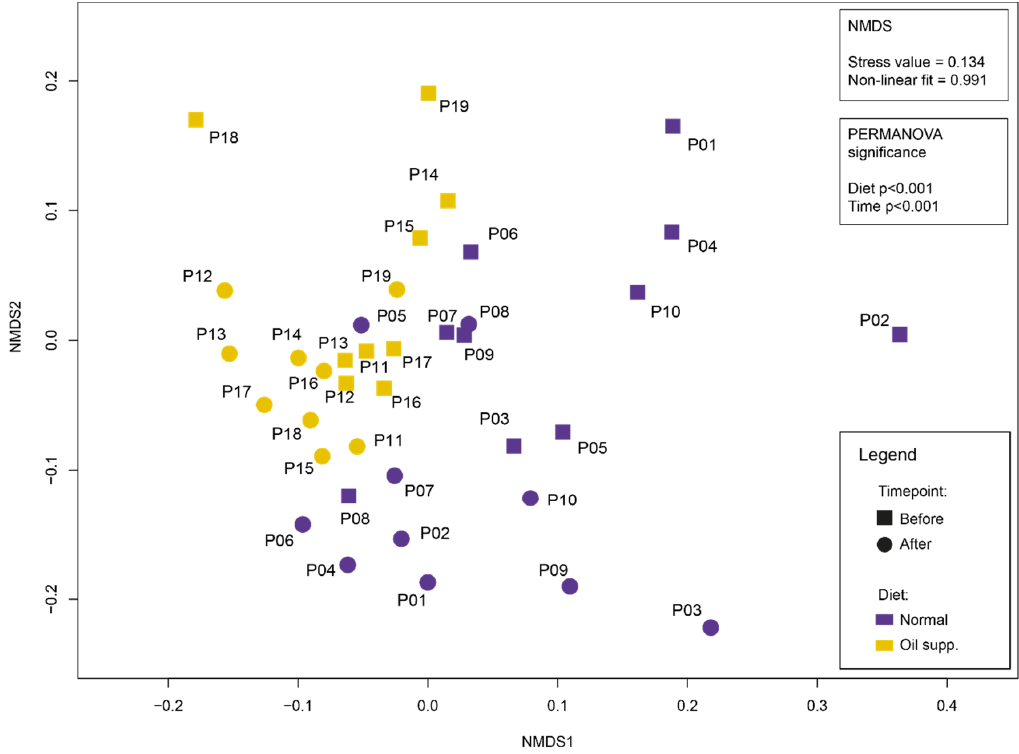
Figure 4. Non-metric multidimensional scaling (NMDS) plot of microbial community composition in the rectal swabs of pigs fed a normal diet and a diet supplemented with coconut oil.